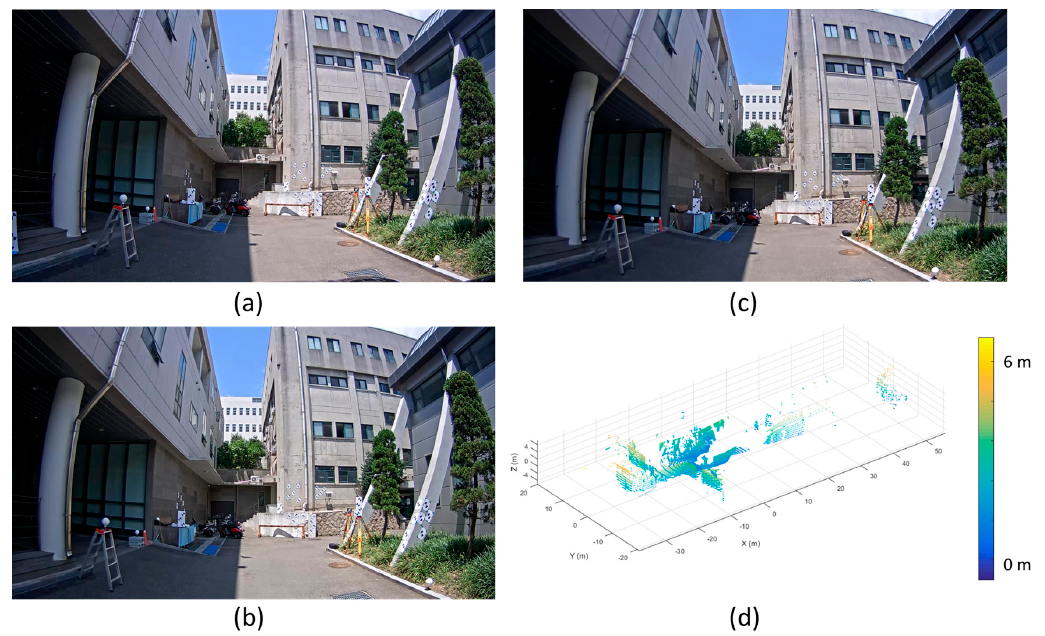
Figure 9. Datasets observed from image and laser sensors in MMS: ( a ) CAM(F) image; ( b ) CAM(L) image; ( c ) CAM(R) image ( d ) mobile laser scanning data (The origin of the coordinate system is center of sensor).